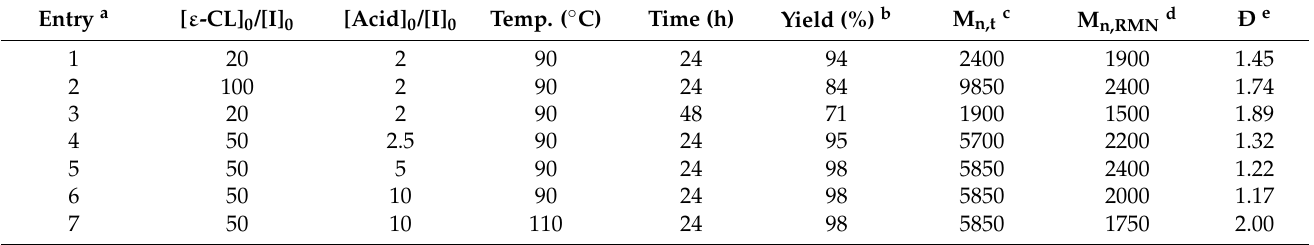
Table 1. Optimization of the polymerization conditions using compound 6 as initiator.